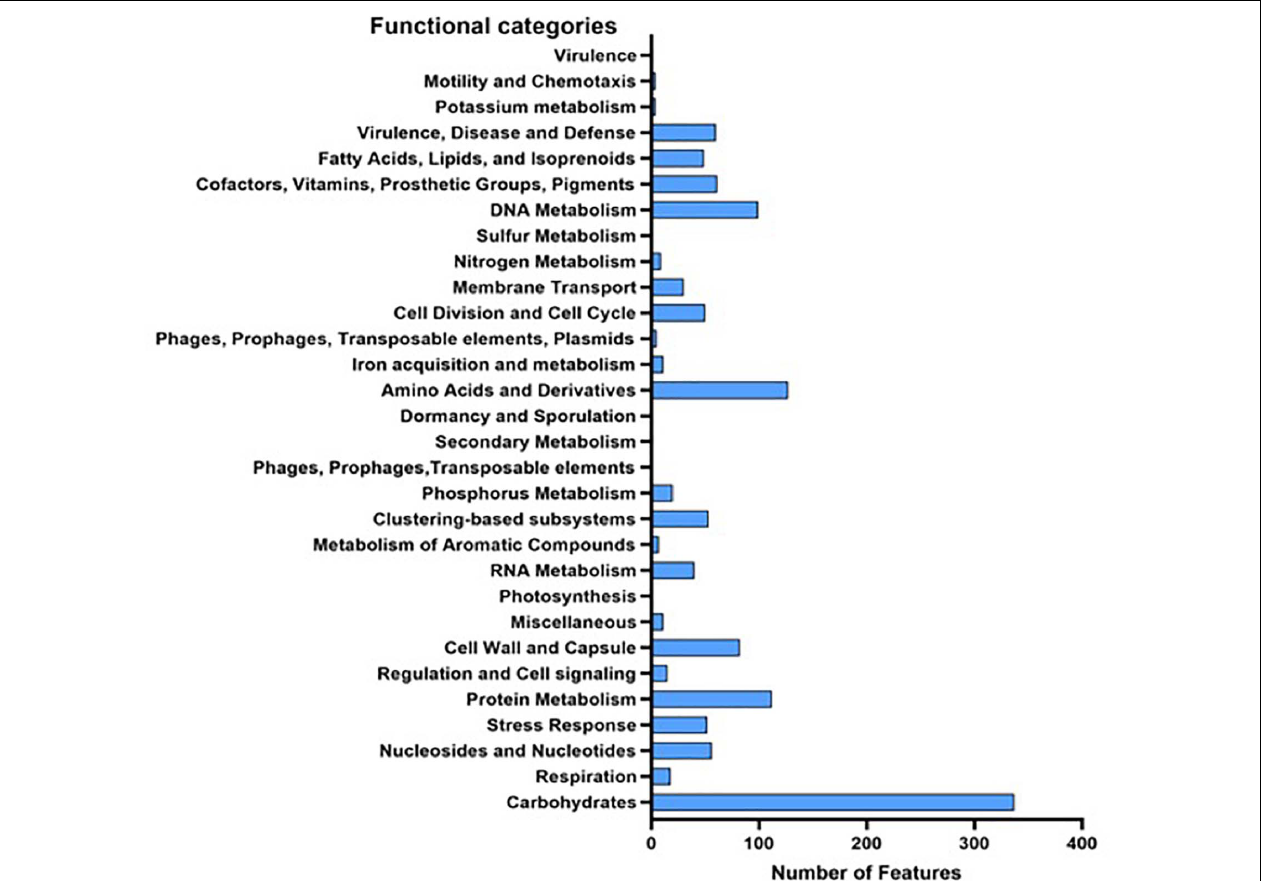
FIGURE 3 | Functional categories of all predicted genes in L. brevis MYSN105 genome based on RAST and Prokka annotation.